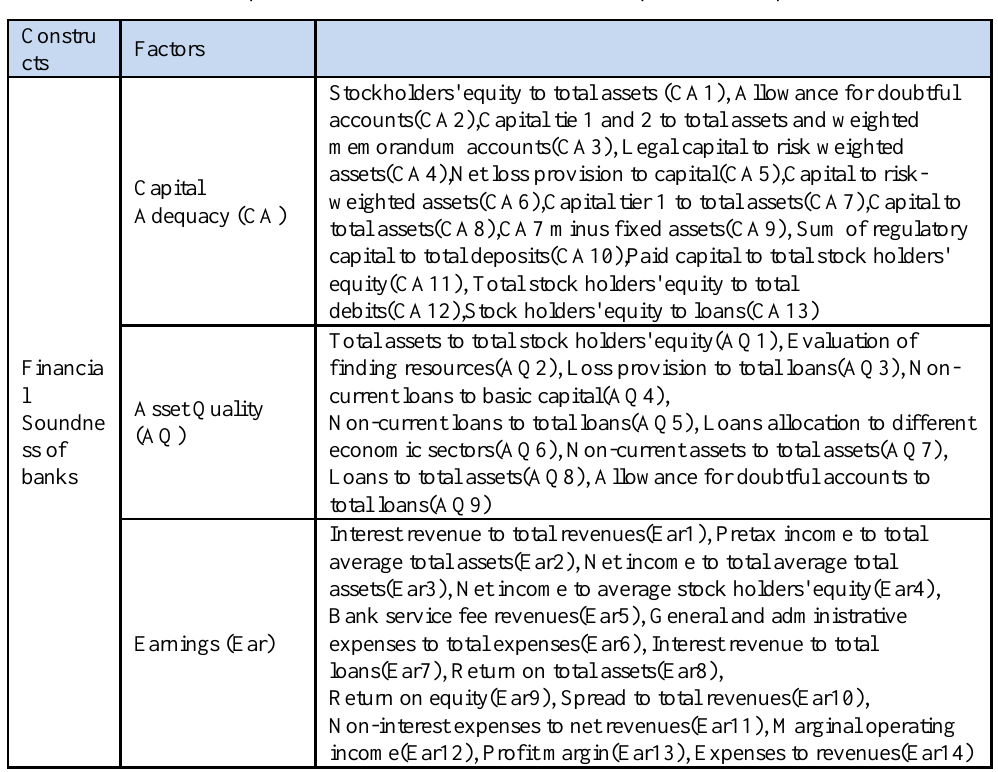
Table 3. Description of financial soundness indicators presented in